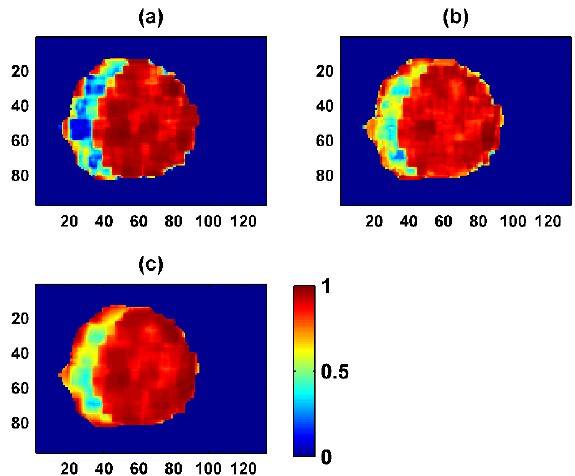
Figure 5. Image of the estimated L w according to Formula (4), namely, the ground scatter ratio. ( a ) HV/HVWeight: L w calculated from complex of HH-VV and HV channel; ( b ) PD/PDWeight: L w calculated from a complex of Phase Diversity; ( c ) MCD/MCDWeight: L w of Maximum Coherence Difference.